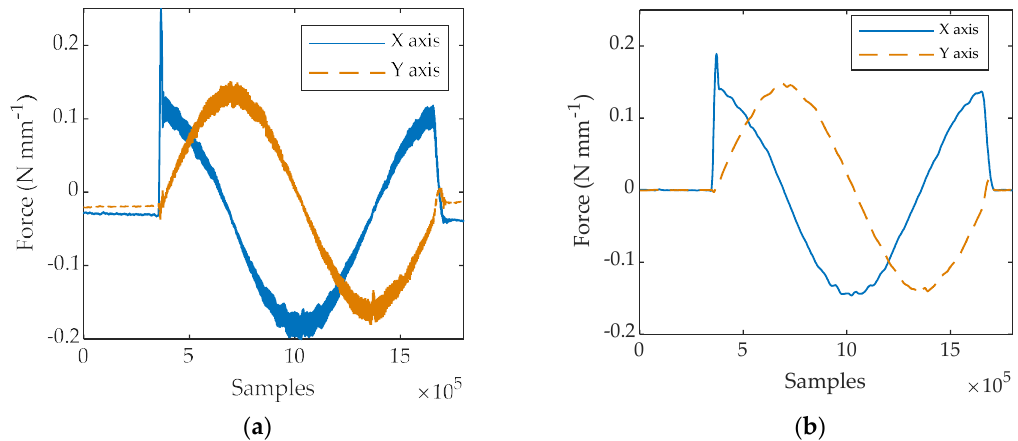
Figure 5. PTFE-machined up-milling with a depth of cut of 1.5 mm forces signals: ( a ) after applying a moving average on 10 cutting periods; ( b ) after applying a moving average on 10 cutting periods and a smoothing on 20 cutting periods. The signals after smoothing were also detrended.